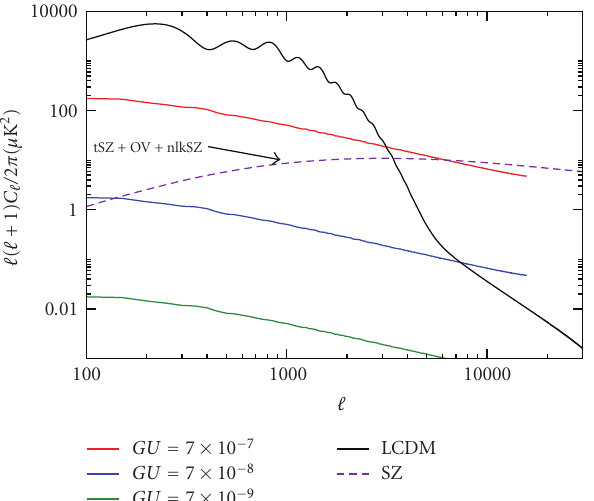
Figure 17: CMB temperature anisotropies from various sources, compared to the expected string contribution. Due to the Silk damping of primordial perturbations, string-induced anisotropies always become dominant for the large multipoles. However, an unresolved SZ e ff ect may compromise such a clean signature